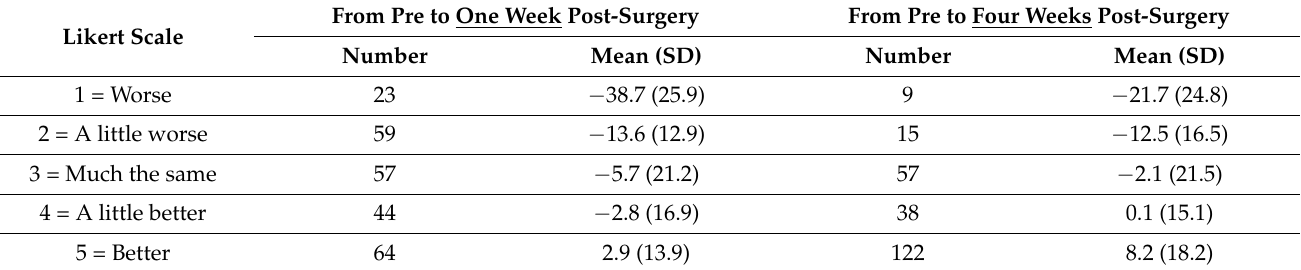
Table 3. The direction of change between the patient “judgement of change” response, and the actual change score between the pre-surgery score and post-surgery QOR-15 PROM